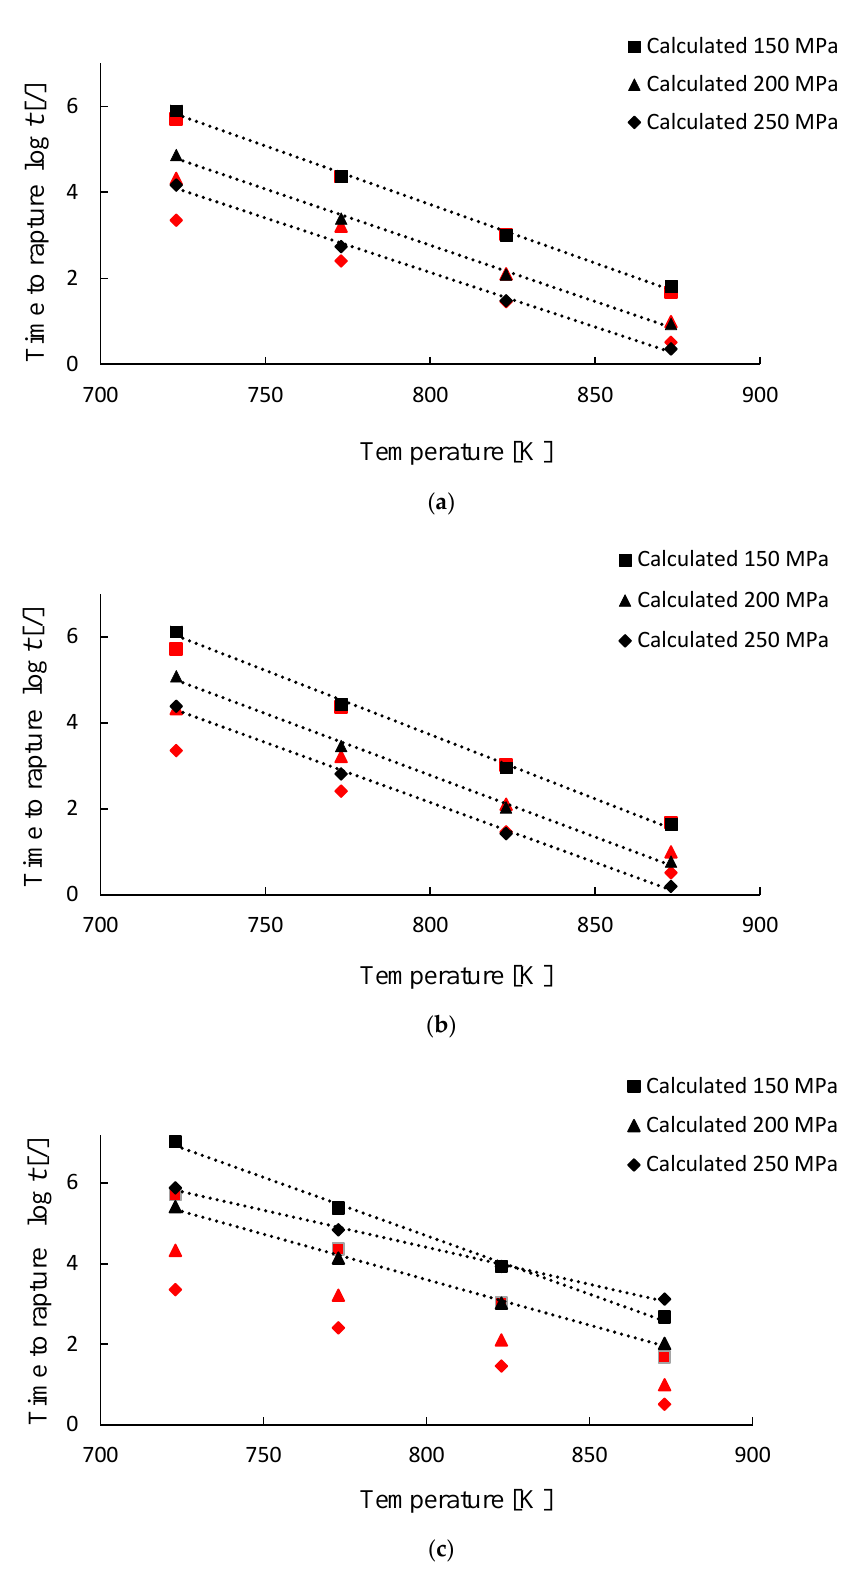
Figure 6. Creep-model performance compared with creep-test results. Model specifications are as follows: polynomial fit function (see Figure 4) and ( a ) C = 18, ( b ) C = 20 and ( c ) C = f ( σ ) with C ( 150 MPa ) = 18.31, C ( 200 MPa ) = 1.25 and C ( 250 MPa ) = 10.20, respectively. Red points represent the measured